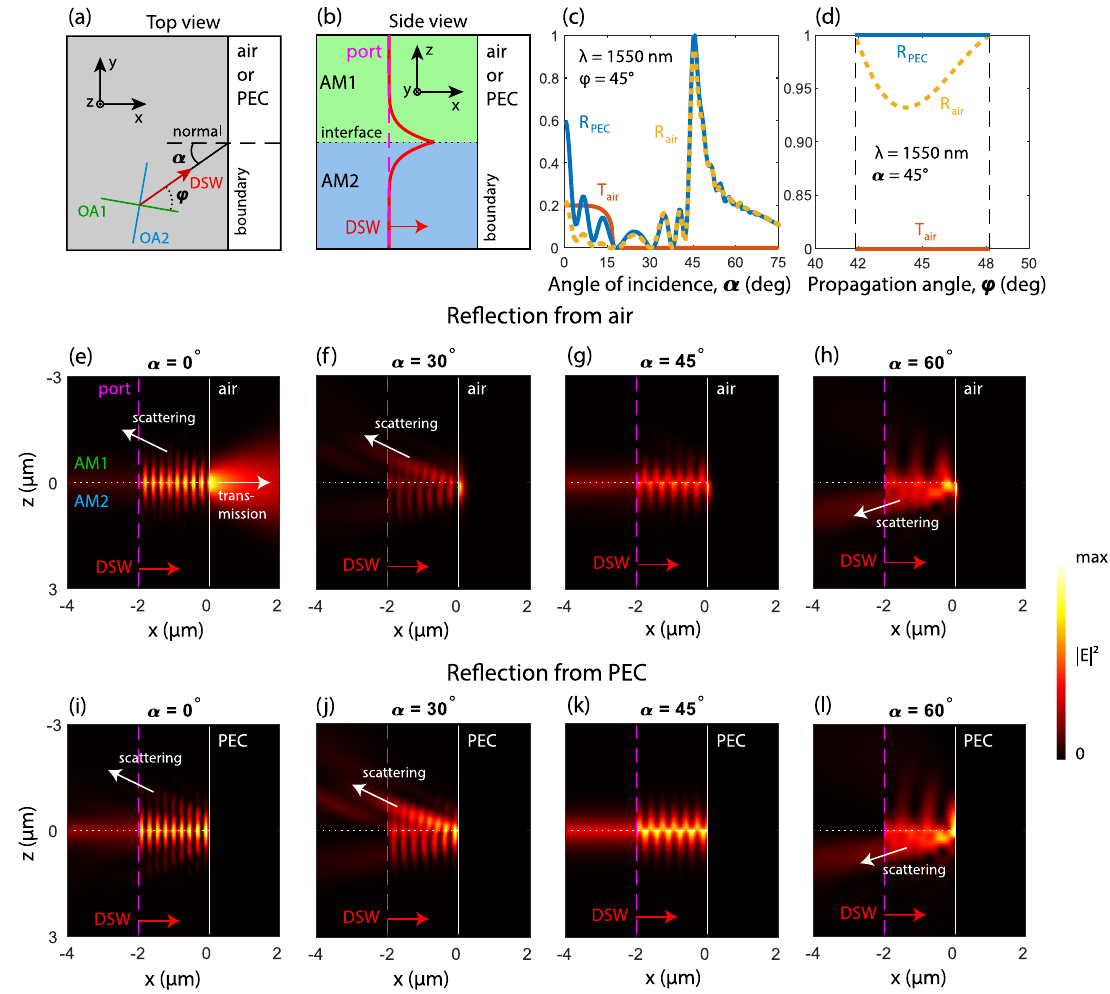
Figure 2: (Color online) Top view (a) and side view (b) of the interface between two anisotropic materials bounded by air or a perfect electric conductor (PEC) half-space on the right. In panel b, the red line schematically shows the Dyakonov surface wave, which is induced by the port denoted by the dashed magenta line, and then hits the boundary. (c and d) The α - and φ -angular dependencies of specular re fl ection and transmissioninsuchacon fi guration.Ind,theblackdashedlinesboundthe φ -rangeoftheexistenceofDyakonovsurfacewaves(DSWs)inthe in fi nite interface. Vertical cross-section of electric fi eld intensity when DSW hits the air boundary (e – h) or the PEC boundary (i – l) calculated at different incident angles α . Arrows show the direction of scattering and transmission. All simulations are made for λ (cid:1) 1550 nm, ε 1 (cid:1) 9 and ε (cid:1) 16. Colorscale is shown on the 2